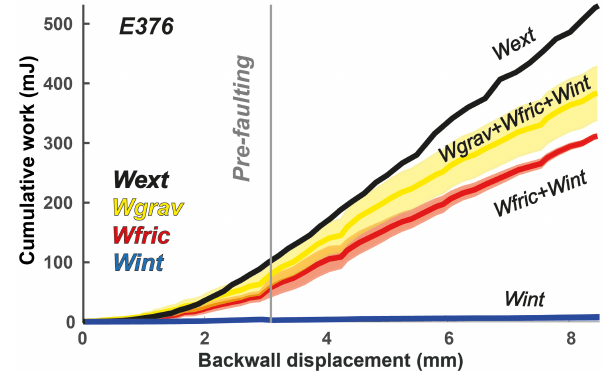
Figure 8. Total accumulation of work done throughout experiment E376. Upper black line shows total W ext . Thicker lines show accu- mulation of work components calculated from average of the left and right displacement fields. Upper and lower edges of shaded re- gions show work accumulation calculated from left and right side views,